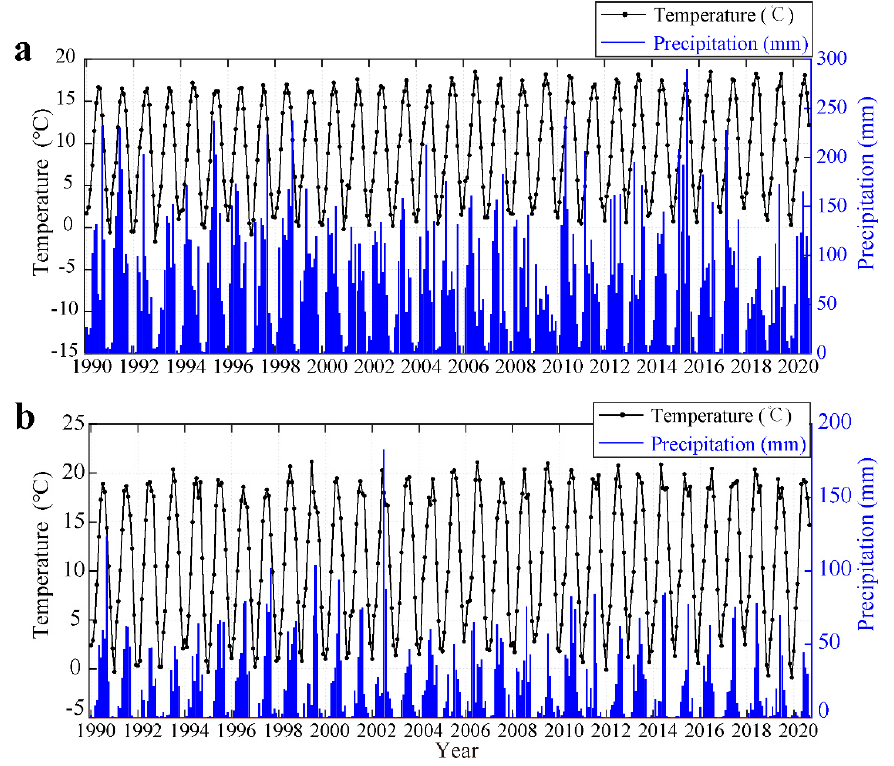
Figure 5. Monthly mean air temperature and precipitation from 1990 to 2020 at the two nearest stations ( a ) Bomi and ( b ) BaXiu; see Figure 1a for location.